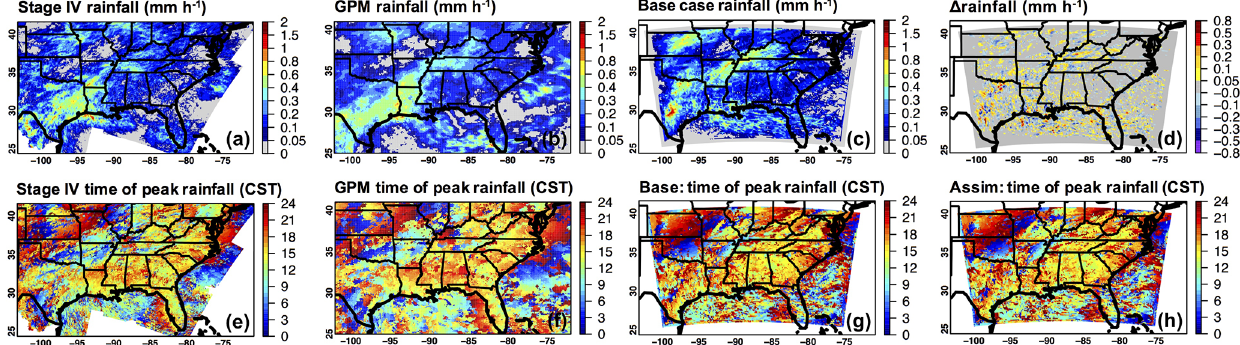
Figure 5. Period-mean (16–28 August 2016) (a–d) rainfall rate and (e–h) time of peak rainfall in US central standard time (CST) from (a, e) the National Stage IV Quantitative Precipitation Estimates product; (b, f) the Global Precipitation Measurement; and (c, g) the WRF- Chem base case. The impacts of the SMAP DA on WRF-Chem results are indicated in (d, g, h)